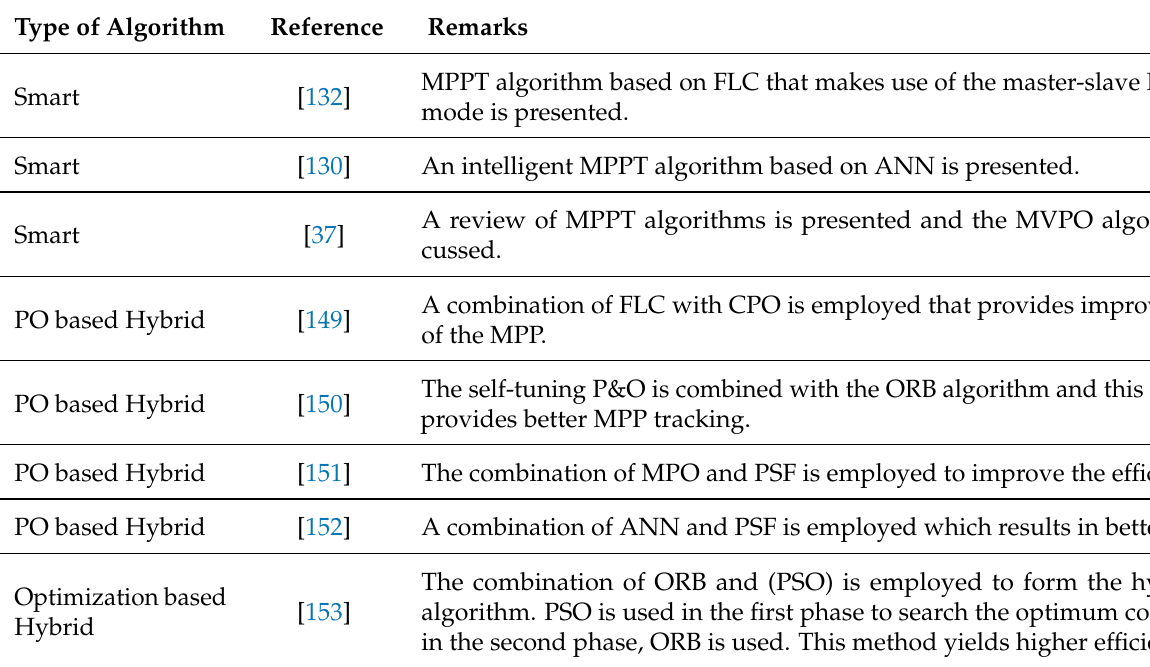
Table 8. Summary of references for Smart and Hybrid MPPT algorithms.